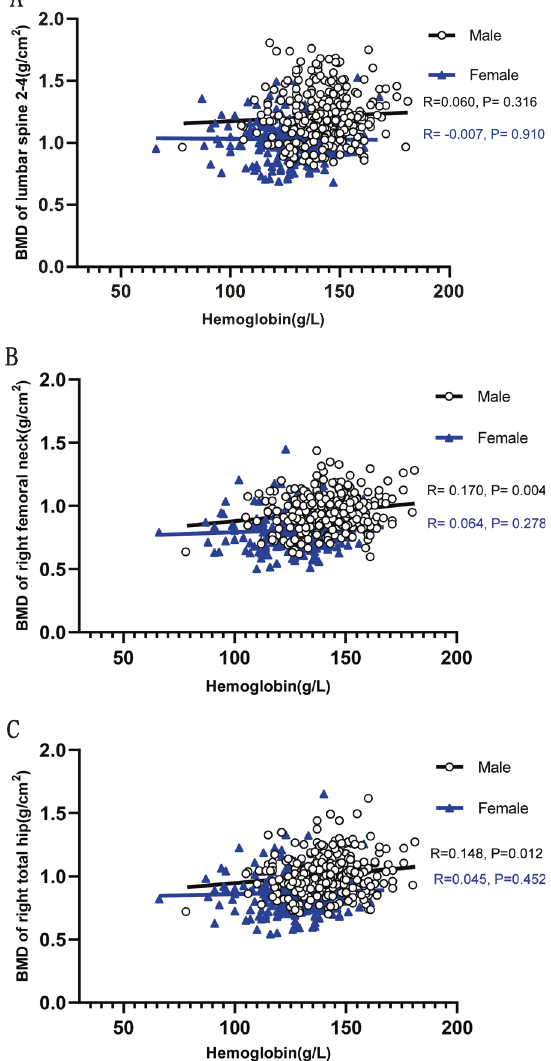
Fig. 3 Correlations between hemoglobin levels and BMD. A Correlations between hemoglobin levels and BMD of the lumbar spine 2-4. B Correlations between hemoglobin levels and BMD of the right femoral neck. C Correlations between hemoglobin levels and BMD of the right total